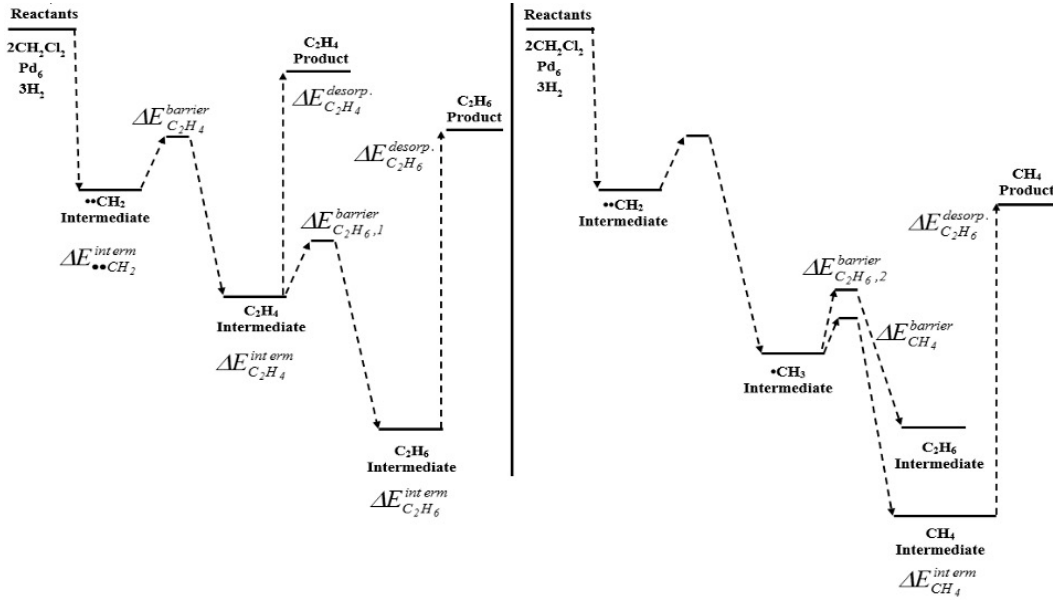
Figure 7. Scheme of reaction mechanism for the HDC of DCM obtained by quantum-chemical calculations for Pd. Reprinted with permission from ref. [33].